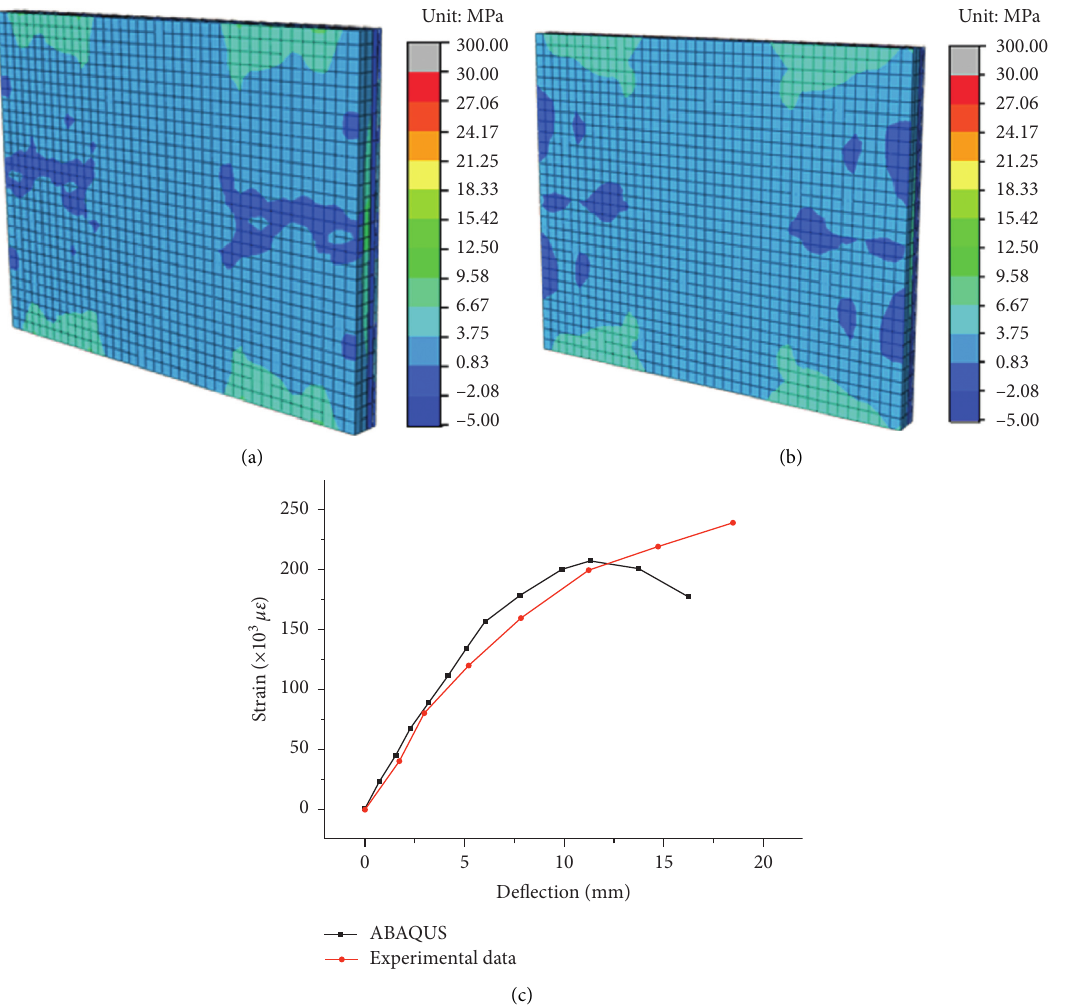
Figure 10: Comparison of the simulation results and the experimental results: the stress nephogram of (a) the four beams loading scheme and (b) the uniformly distributed loading scheme; (c) the load-deflection